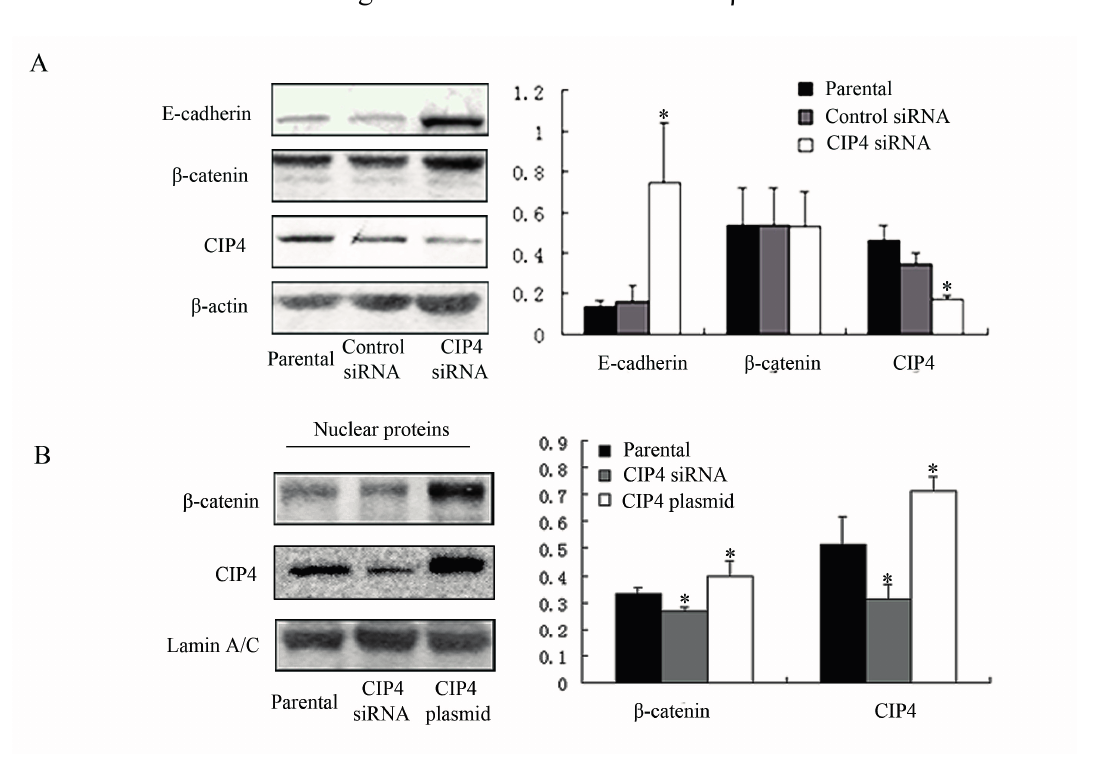
Figure 4. CIP4 depletion reverses the expression of E-cadherin and regulates translocation of β -catenin. Western blots for protein expression of ( A ) E-cadherin, β -catenin, and CIP4 in whole cell lysates of parental, control siRNA-transfected, and CIP4 siRNA-transfected cells; and ( B ) β -catenin and CIP4 in nuclear proteins of parental, CIP4 siRNA-transfected, and CIP4 plasmid-transfected cells. Histograms show the average volume density normalized to the loading control β -actin in ( A ) and Lamin A/C in ( B ), ( n = 3); * p < 0.05 compared with parental